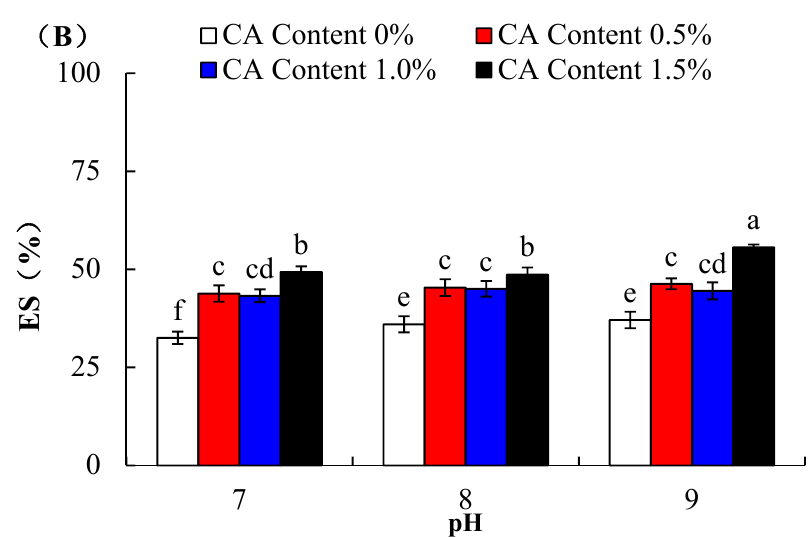
Figure 4. Emulsifying activity ( A ) and emulsion stability ( B ) of WPI incubated with CA (0%, 0.5%, 1.0%, and 1.5%) at pH 7.0, pH 8.0, or pH 9.0, and at 50 °C for 6 h. Error bars represent the standard deviation of the mean of triplicate experiments. Values with different letters are significantly different ( p < 0.05).